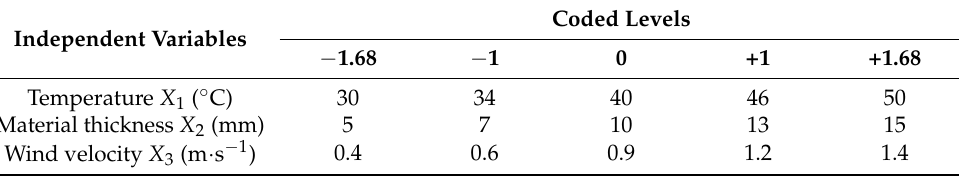
Table 1. Experimental values and coded levels of the independent variables in central composite rotatable design.